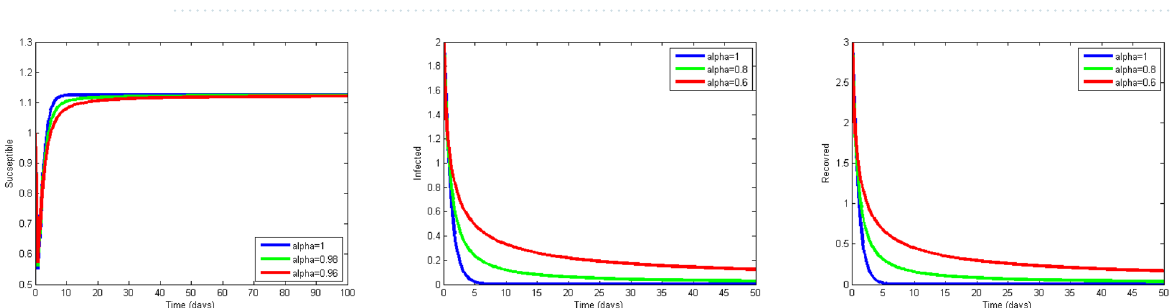
Figure 3. Dynamics of the system (3.2) for α = 0.6 .